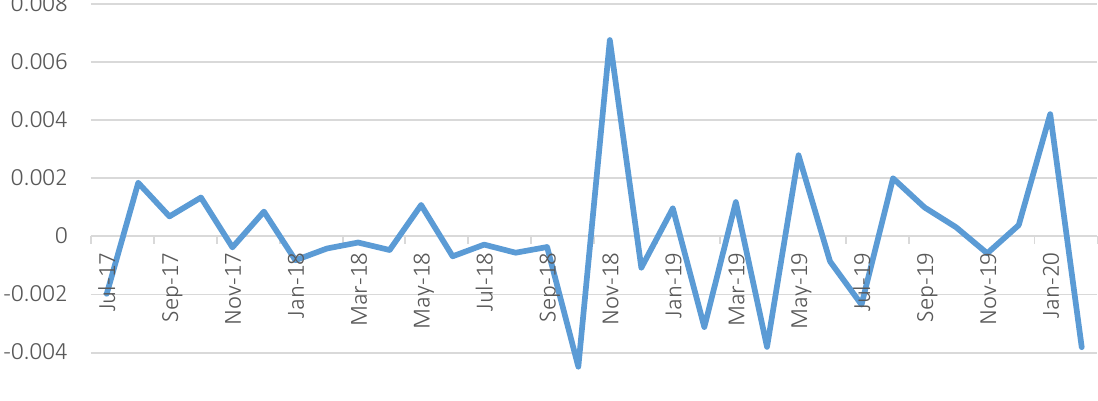
Figure 4. RMSE from the dynamic forecasts of